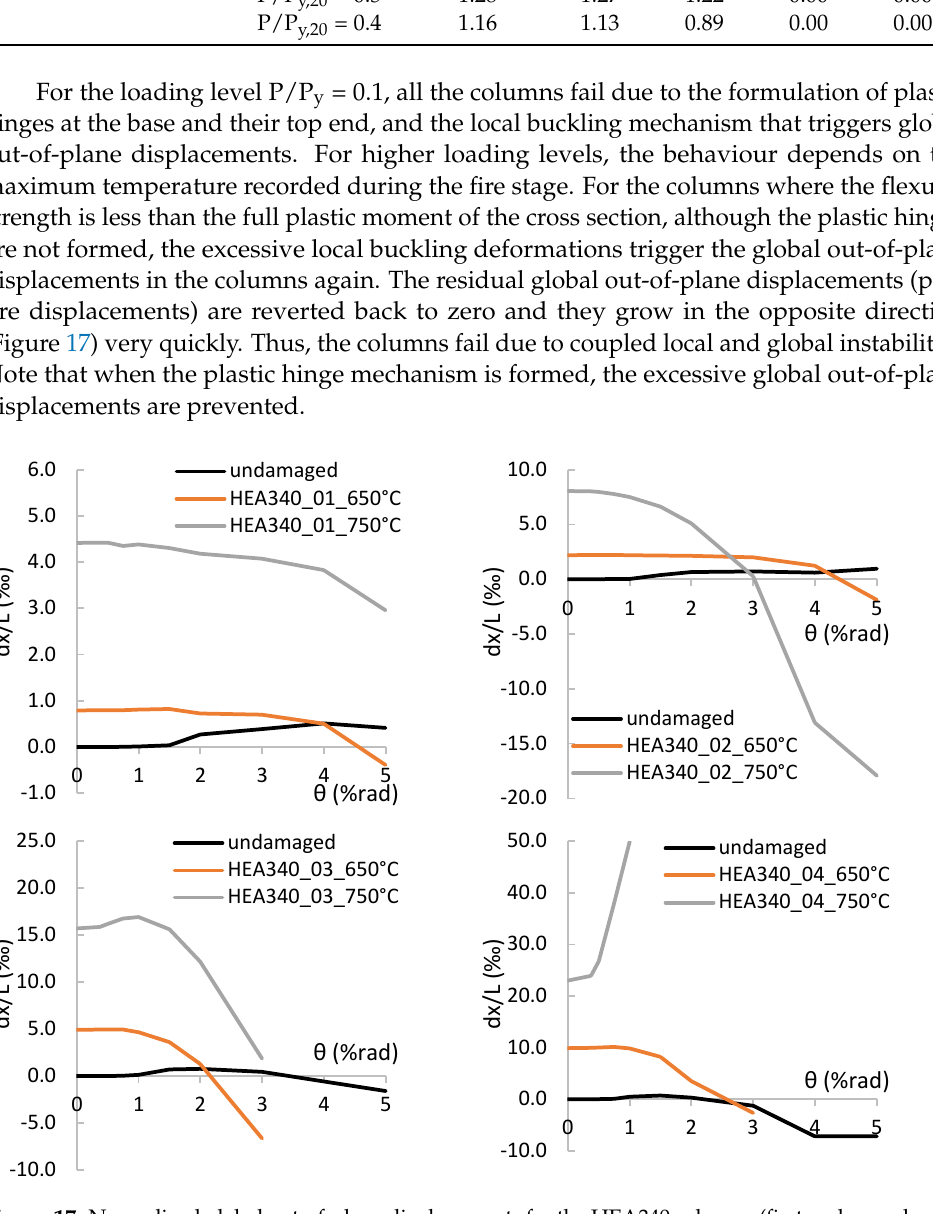
Figure 17. Normalized global out-of-plane displacements for the HEA340 columns (first cycle enve ‐ lopes).